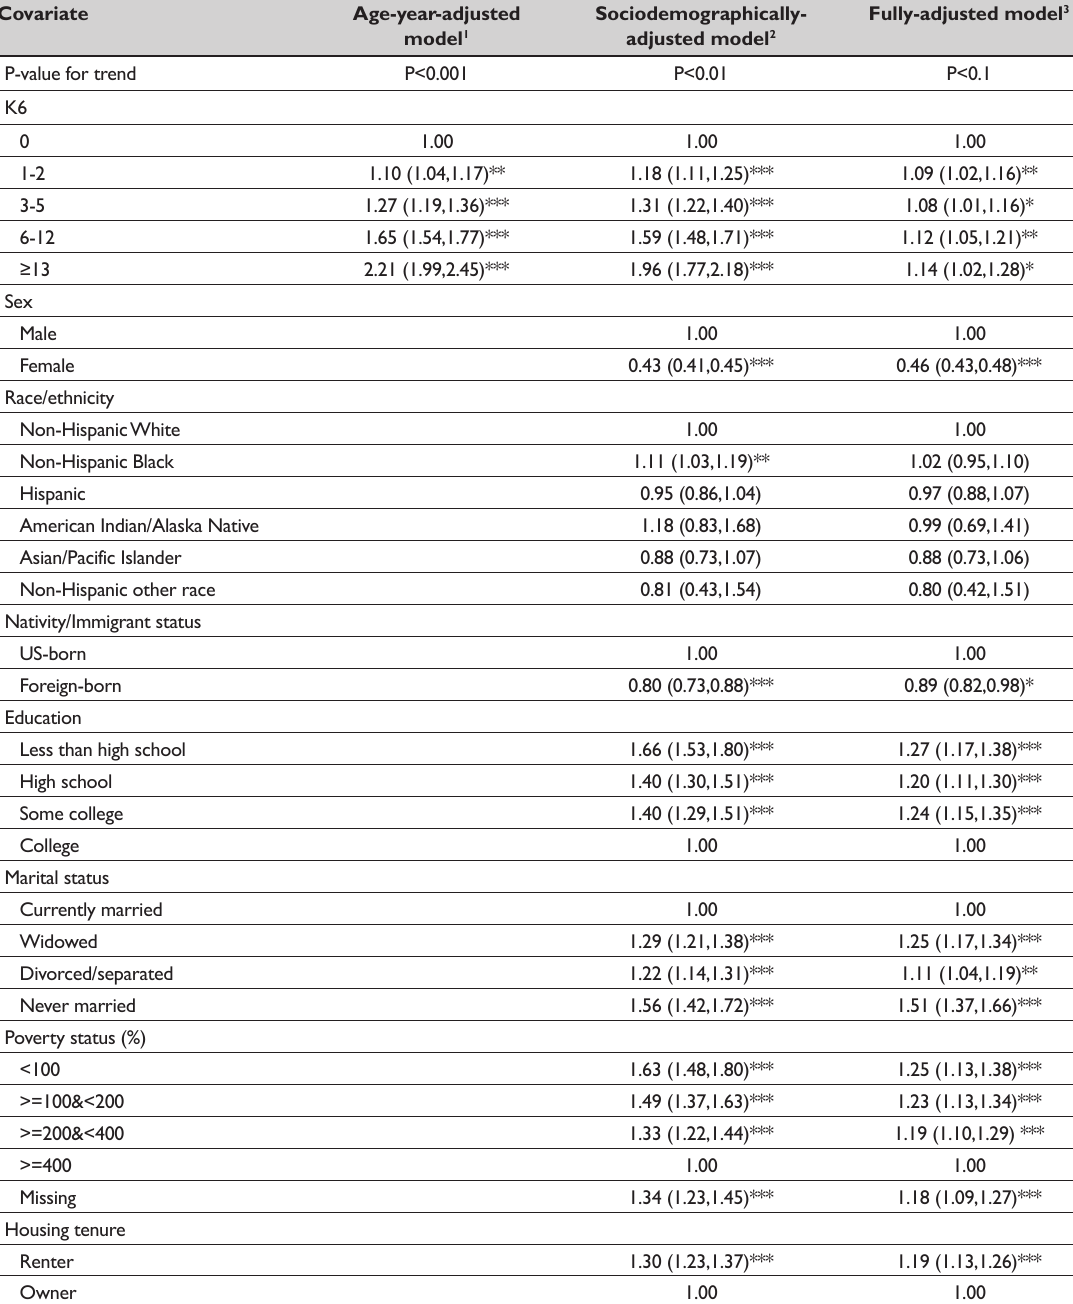
Table 3: Age-year-adjusted and covariate-adjusted hazard ratios (HRs) of heart disease mortality (derived from multivariate Cox models) by psychological distress levels among US adults aged ≥18 years, 1997-2014